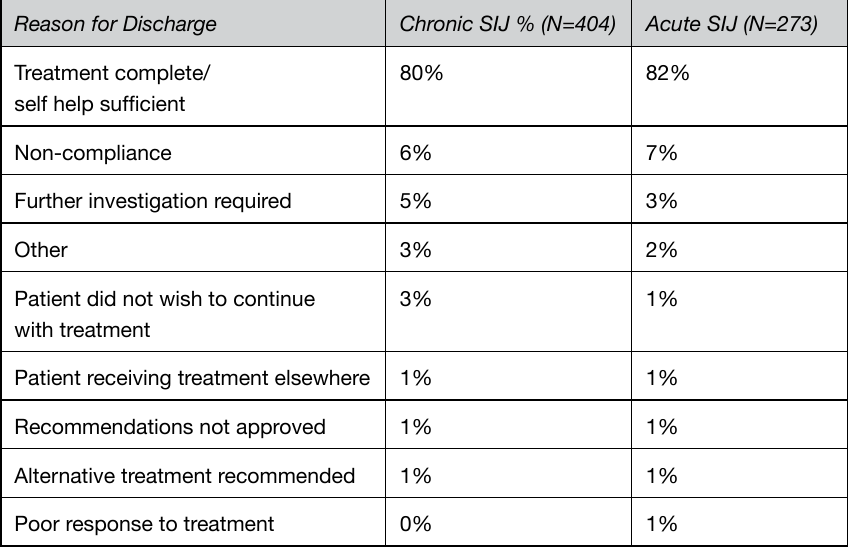
Table 2: response to treatment based on clinician selected ‘reason for discharge’ Reason for